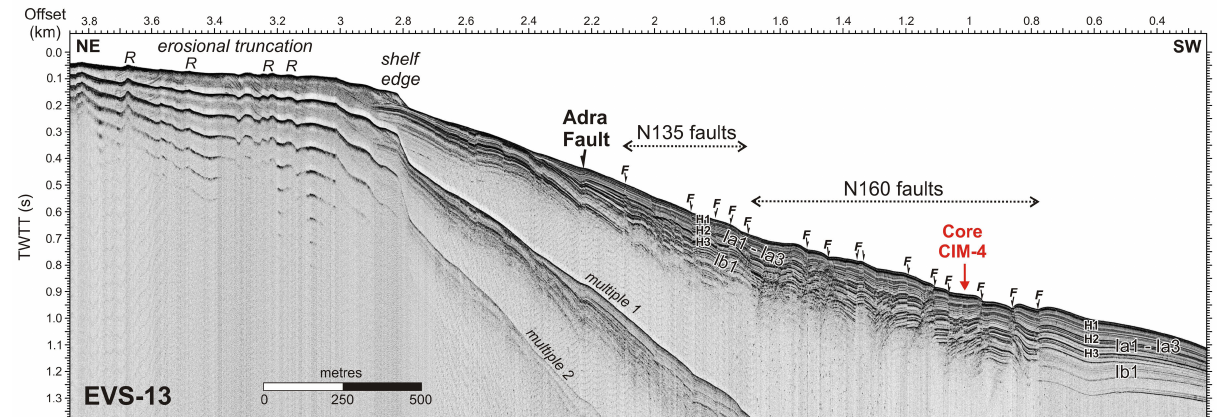
Fig. 4. Regional Sparker profile EVS-13 from the shelf to the middle slope. The Adra Fault and its parallel N135 faults together with the neighbouring N160 faults are imaged. Sediment core CIM-4 is located. Age of horizons are H1: Late Quaternary, H2: Early Quaternary (1.8Ma), and H3: Late Pliocene (3.6Ma). Vertical exaggeration at the seafloor ∼